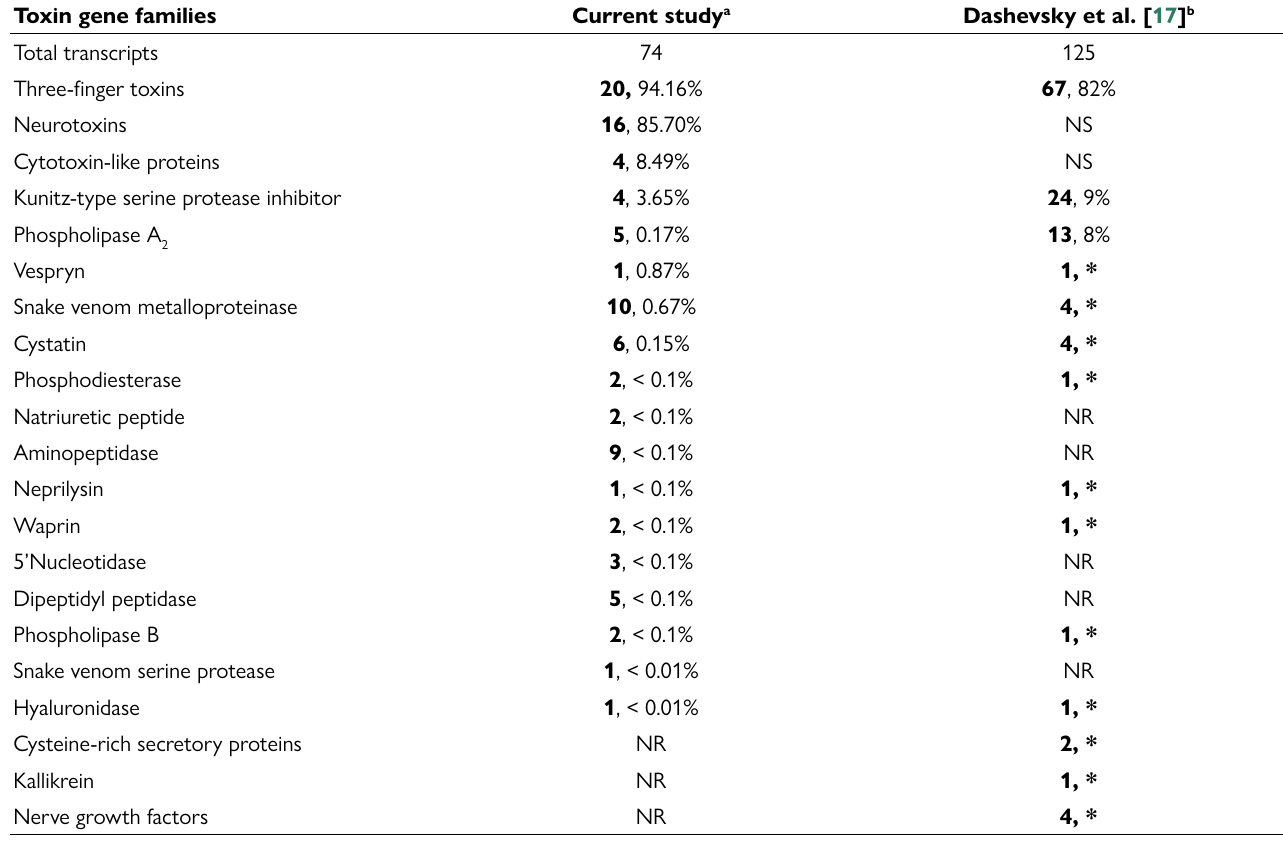
Table 3. Comparison of venom gland transcriptomics of the Malayan blue coral snake ( Calliophis bivirgata ) between two studies. Toxin gene